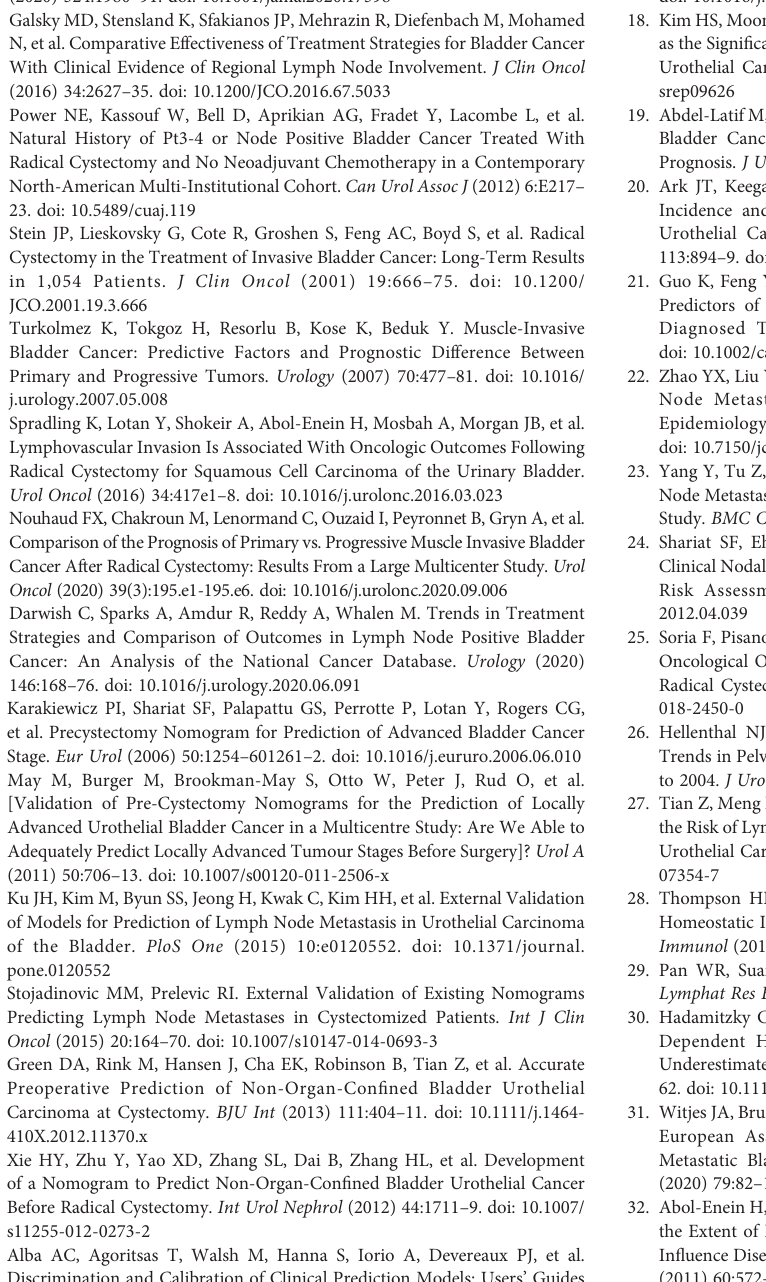
Calibration curve of the 3- (A) and 5-year (B) OS nomograms in the training set (bootstrap method, 1000 repetitions). (C) Area under the curve for predicting the OS of patients with BCA in the training and validation sets. (D) The DCAcurve ofthe training set. The x-axis represents the threshold probability, and the y-axis represents the net bene fi t. The black line indicates that all patients are at low risk, whereas the green line indicates that all patients are at high risk.